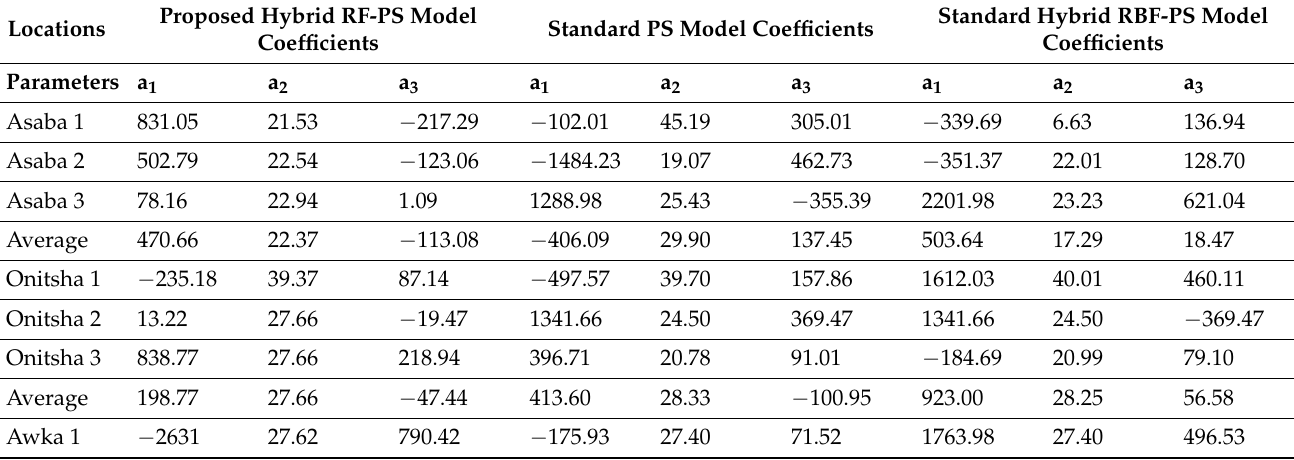
Table 3. The Coefficients of the developed path loss model using the proposed hybrid RF-PS and other existing standard